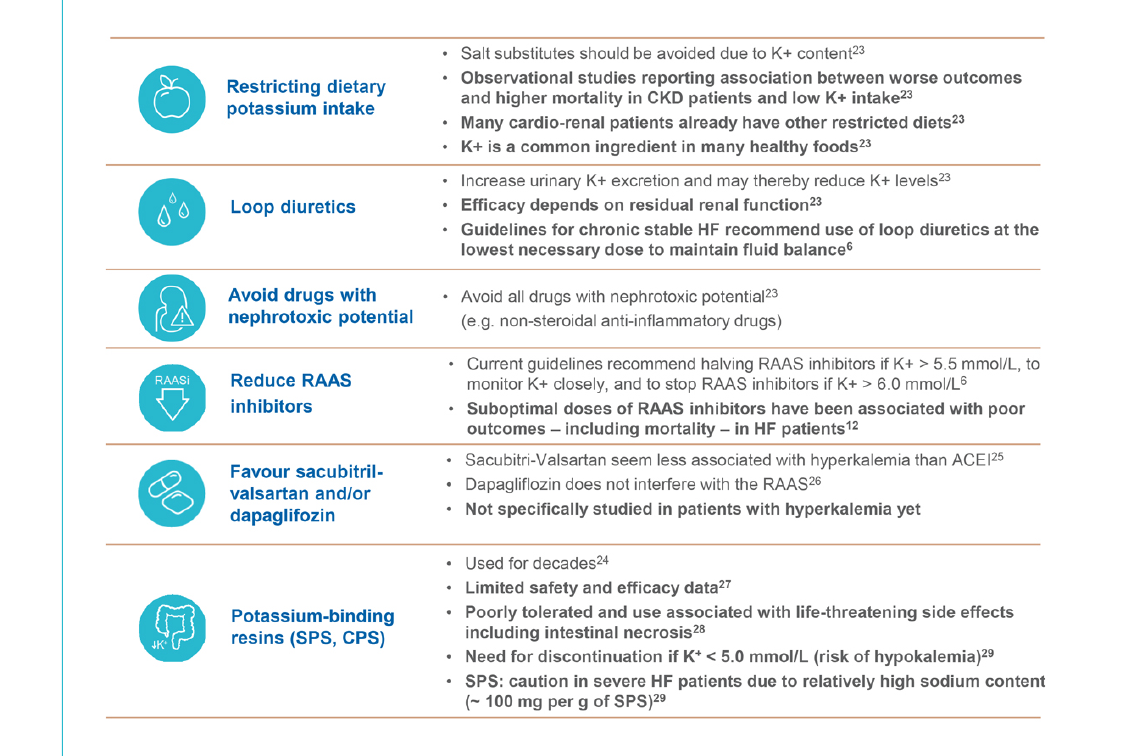
Figure 1: Strategies currently available to treat chronic hyperkalaemia and their limitations.CPS = calcium polystyrene sulphonate; CKD = chronic kidney disease; HF = heart failure; K + = potassium; RAAS = renin-angiotensin-aldosterone system; SPS = sodium polystyrene